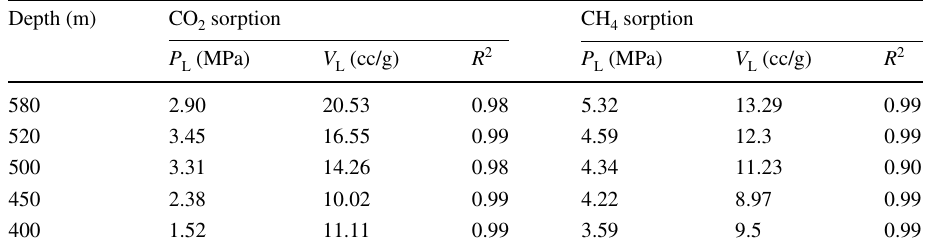
Fig. 8 Effect of moisture content on sorption capacity of coal. a CO 2 sorption and b CH 4 sorption